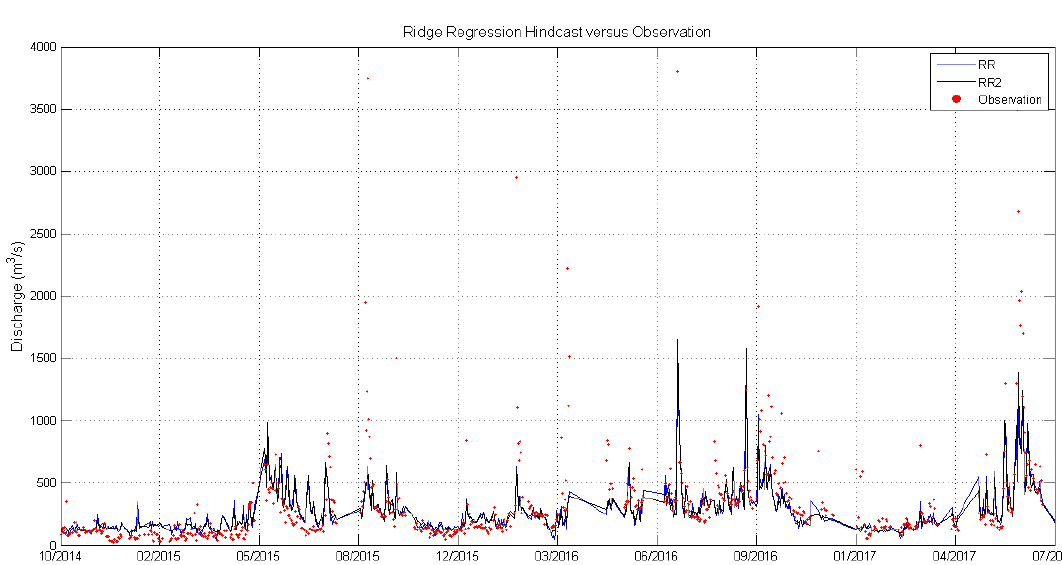
Table 9. RR2’s verification performance (daily, n = 857).